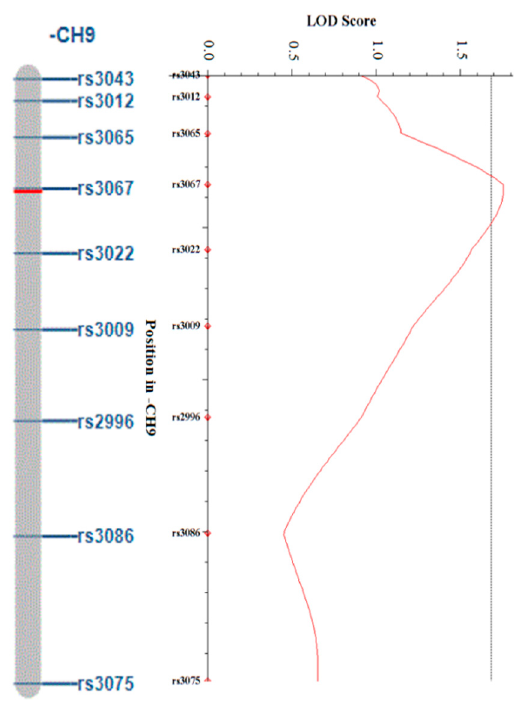
Figure 6. LOD score plots for chromosome 9 containing QTL with LOD score of 1.75 (GX71). The horizontal lines indicate the thresholds for the LOD.